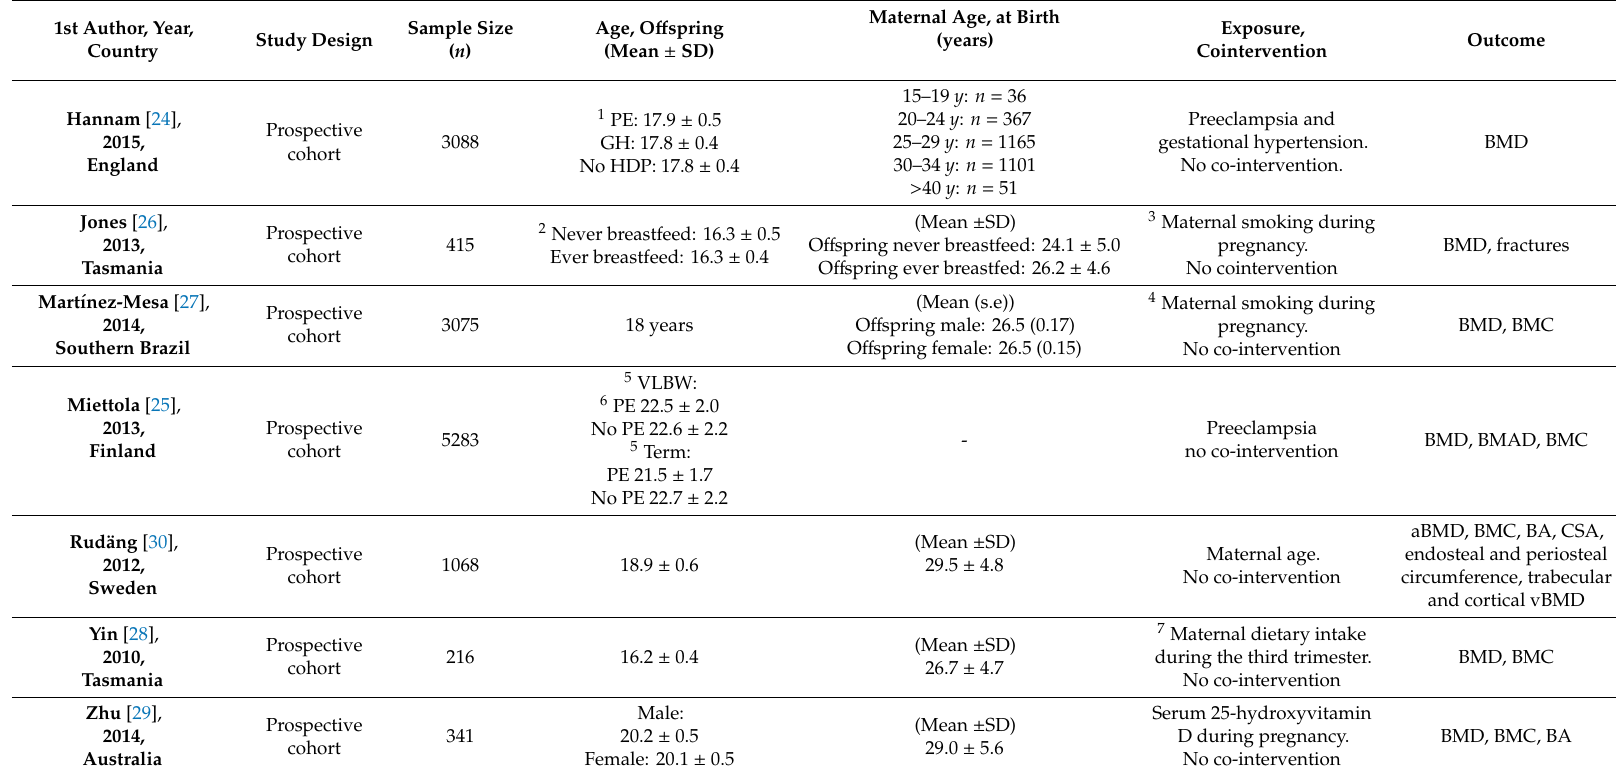
Table 1. Characteristics of the included